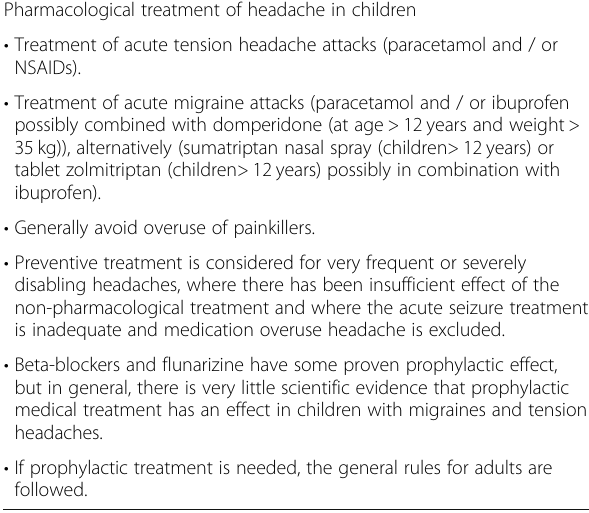
Table 23 Pharmacological treatment of headache in children Pharmacological treatment of headache in